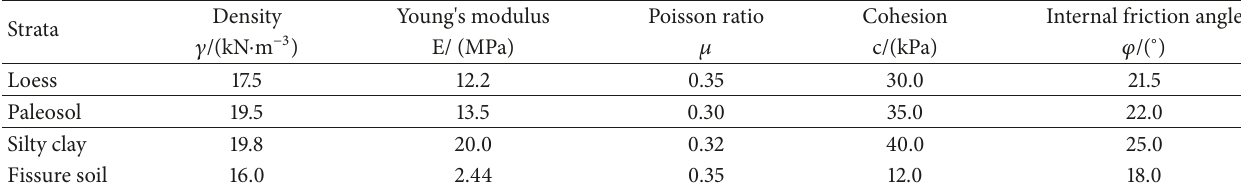
Table 1: Parameters of strata and